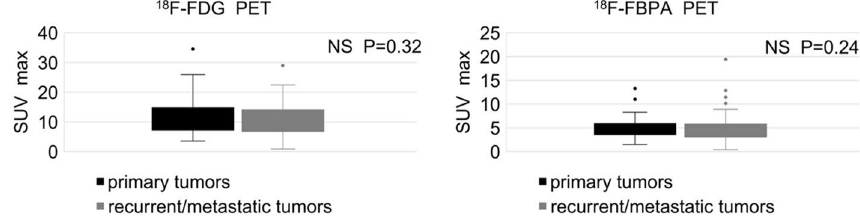
Fig. 1 SUVmax of 18 F-FDG and 18 F-FBPA PET/CT for primary tumors vs. recurrent or metastatic